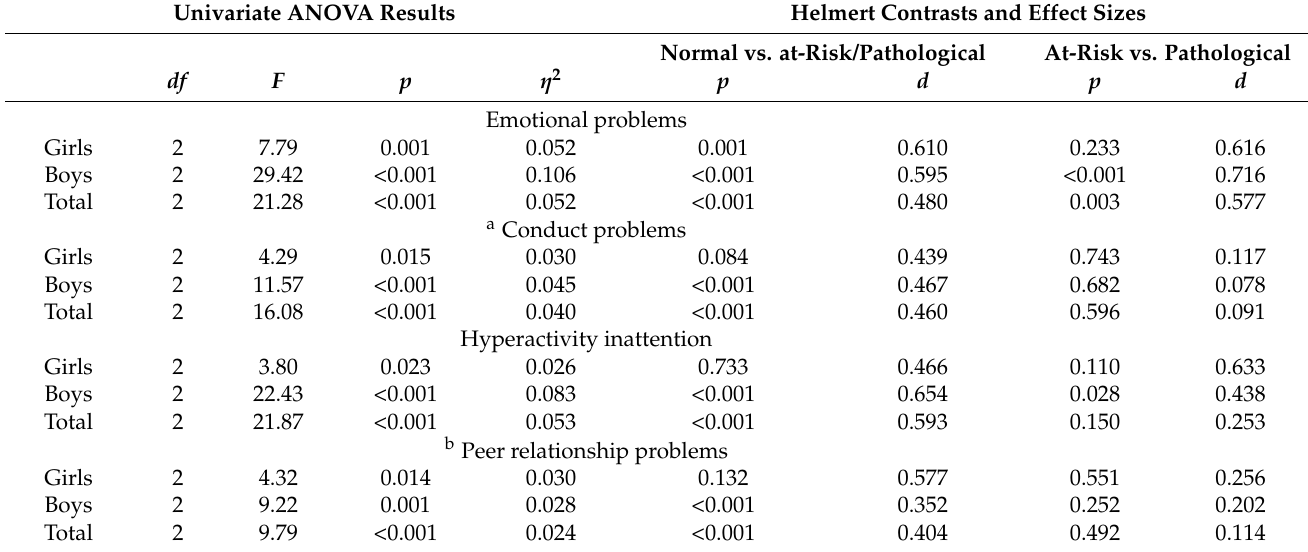
Table 8. SDQ subscales scores (2018 sample): results of significance tests between IGDS gaming groups, Helmert contrasts and effect sizes for Table